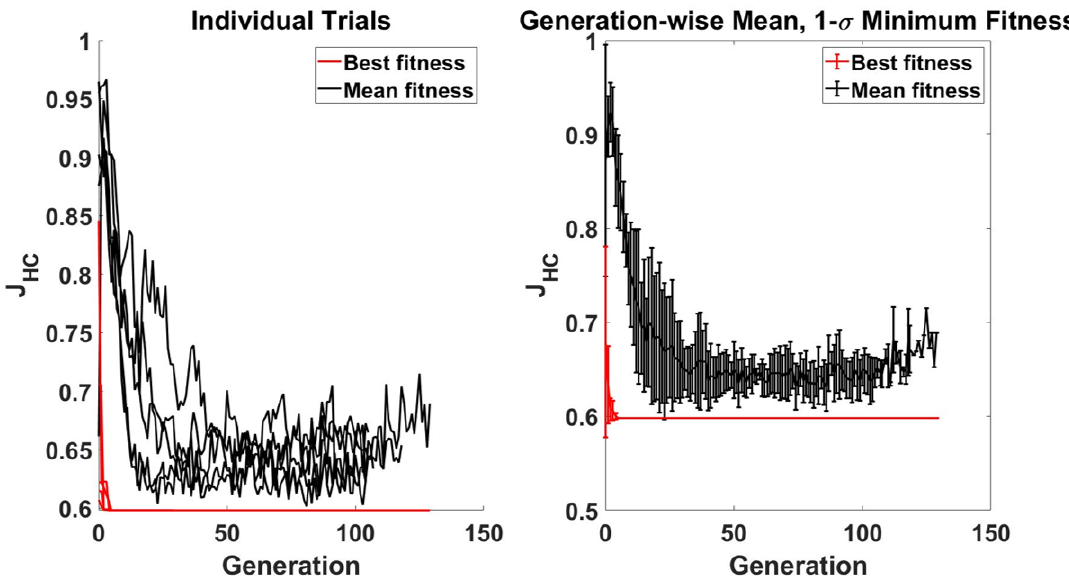
Figure 12. Variation of the heliocentric cruise fitness for the Perseus mission concept across different GA populations generations showing: the individual optimization trials ( left ); and their statistical distribution ( right ).